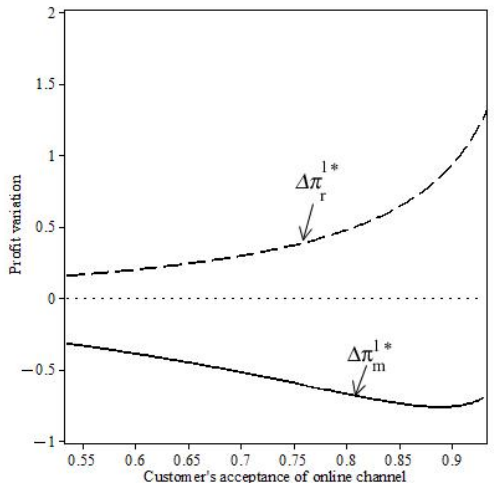
Figure 1. The impact of θ on the profit variation under Mechanism 1.